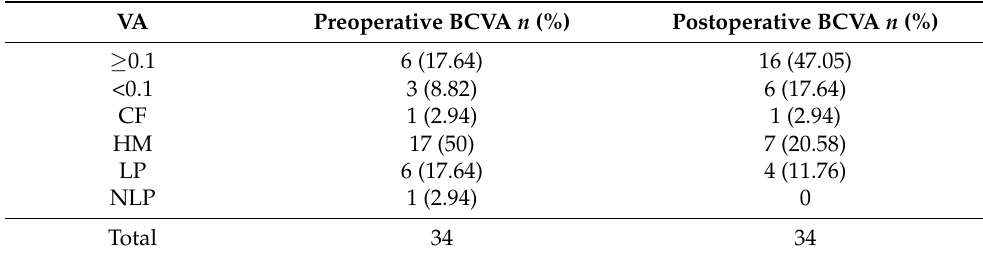
Table 3. Visual outcome in patients with post-traumatic